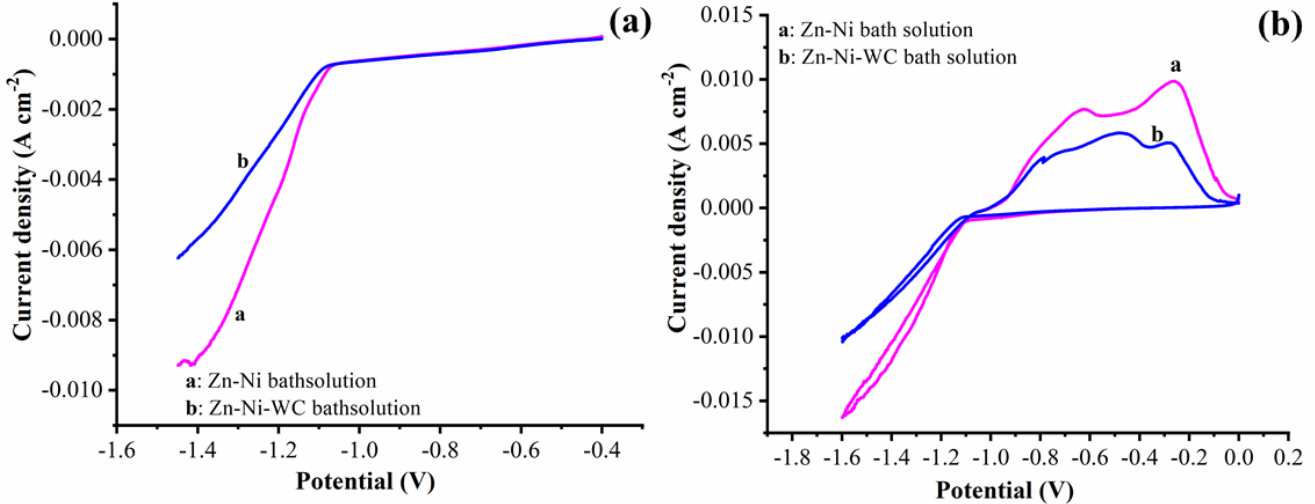
Figure 4. Zn–Ni alloy and Zn–Ni–WC composites result showing ( a ) Cathodic PC ( b ) Cyclic Voltammograms.